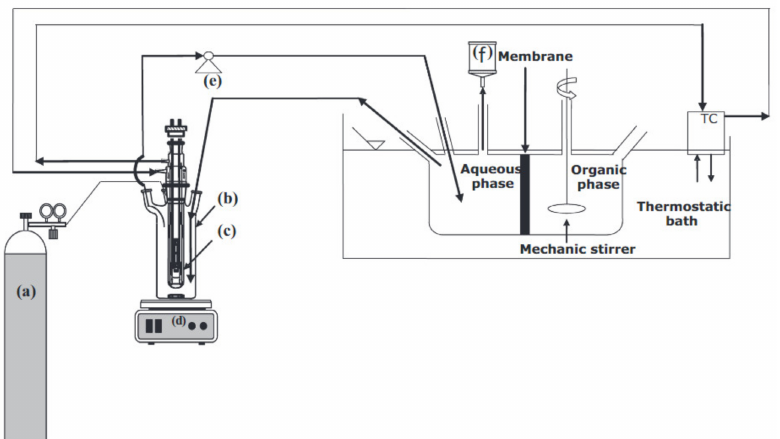
Figure 3. Scheme of the membrane contactor integrated with the batch photoreactor: ( a ) argon cylinder; ( b ) photoreactor; ( c ) medium pressure Hg lamp with cooling jacket; ( d ) magnetic stirrer; ( e ) peristaltic pump; ( f ) degassing system; (TC) temperature controller